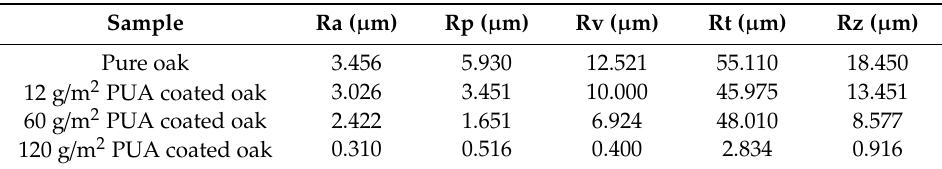
Table 6. Roughness of oak before and after coating at di ff erent coating amount.